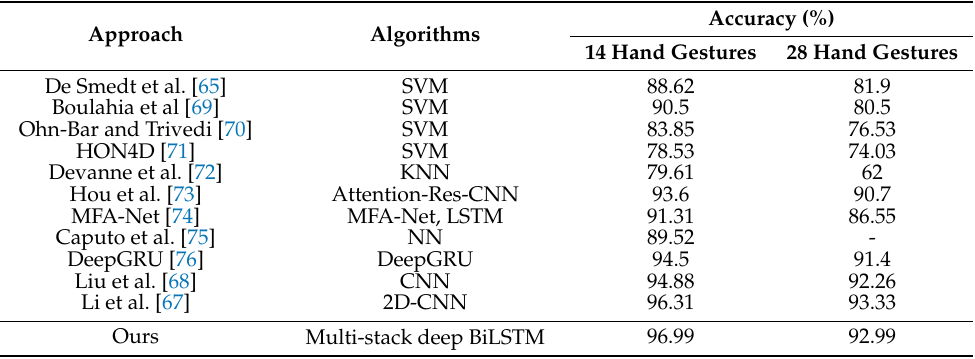
Table 13. Performance of the multi-stacked BiLSTM network initialized with data-driven optimization applied to SHREC data set.